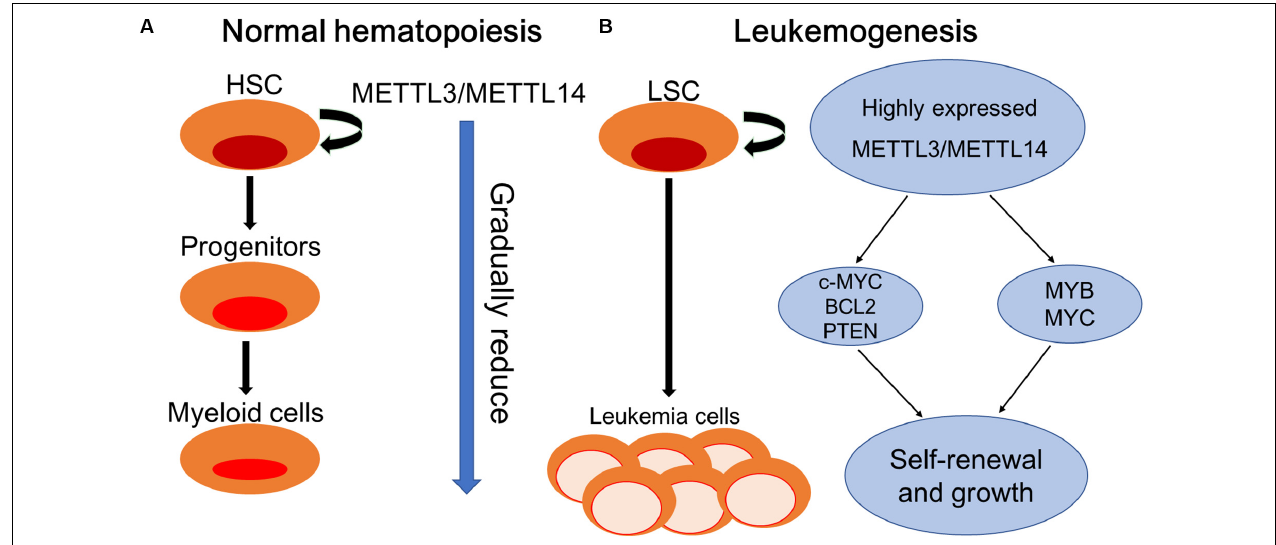
FIGURE 2 | Schematic elucidation of normal hematopoiesis and leukemogenesis. (A) Normal hematopoiesis: hematopoietic stem cells (HSCs) differentiate into myeloid progenitors and eventually mature myeloid cells. METTL3/METTL14 are highly expressed in hematopoietic stem and progenitor cells (HSPCs) and are downregulated during normal differentiation. (B) Leukemogenesis: myeloid differentiation of HSPCs is blocked to produce self-renewing LSCs. METTL3/METTL14 are aberrantly expressed in leukemia stem cells (LSCs). METTL3 promotes the self-renewal and growth of LSCs by enhancing the translation of c-MYC, BCL2, and PTEN mRNAs. METTL14 promotes self-renewal and growth through the induction of MYB and MYC mRNA translation.